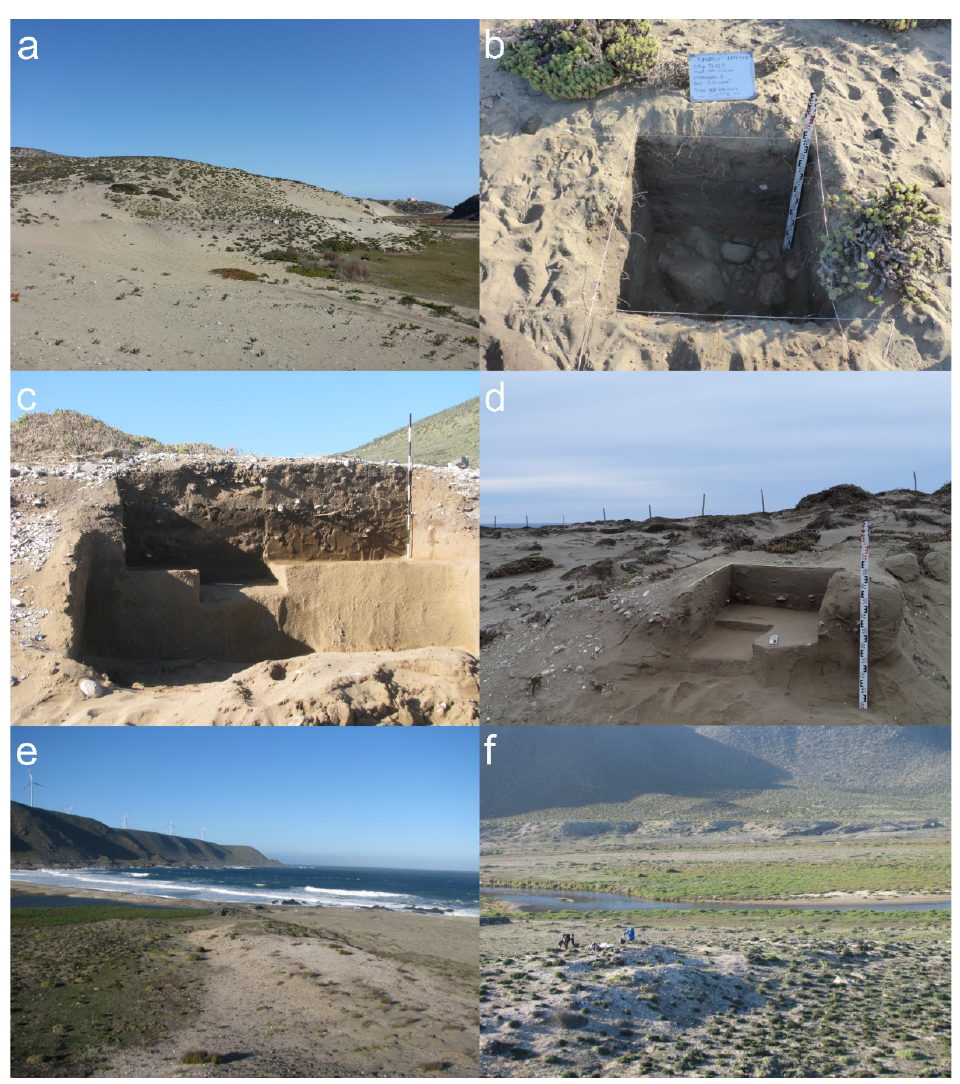
Figure 3. Images of the selected sites in El Teniente Bay: ( a ) La Cebada (TE01A); ( b ) La Cebada (TE01B), ( c ) Las Corvinas 1 (TE04); ( d ) Las Corvinas 2 (TE05); ( e ) mound A and ( f ) mound C of the Quebrada San Pedro Norte site (TE06).